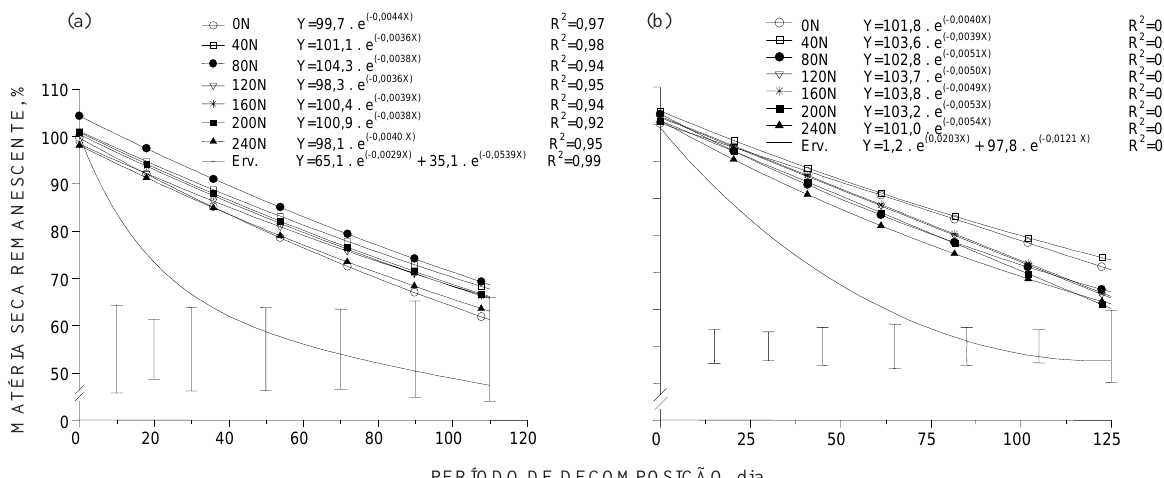
Figura 1. Decomposição dos resíduos culturais de ervilhaca e aveia preta sob sistema plantio direto, avaliada por meio de sacos de decomposição nos anos de 1998 (a) e 1999 (b). As barras verticais indicam a diferença mínima significativa (DMS) pelo teste Tukey a 5 %.